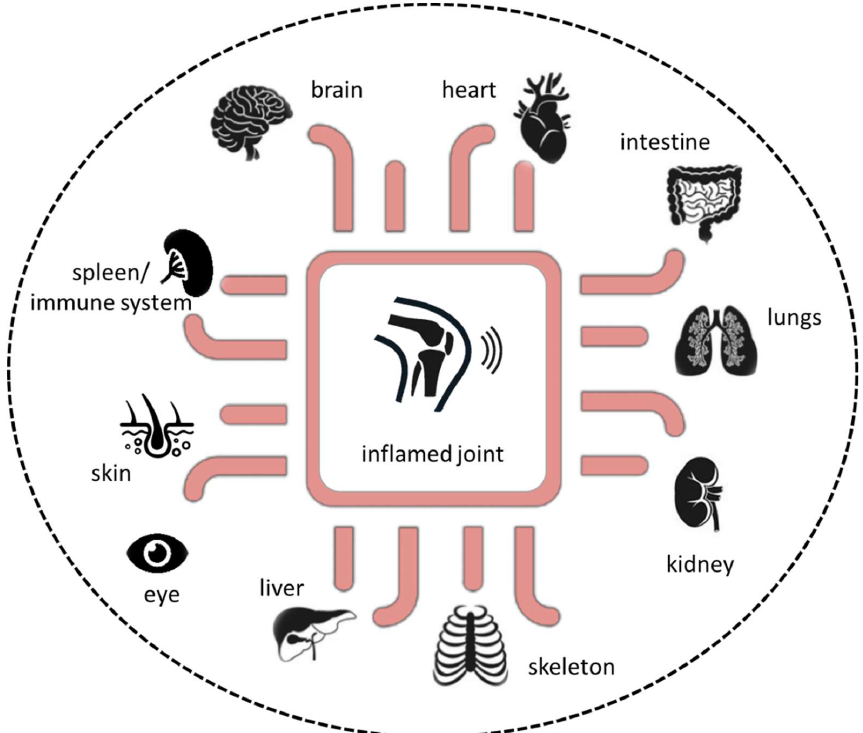
Figure 4. Next-generation preclinical in vitro approach based on microphysiological in vitro human- joint-on-a-chip systems in combination with pathophysiological-relevant human